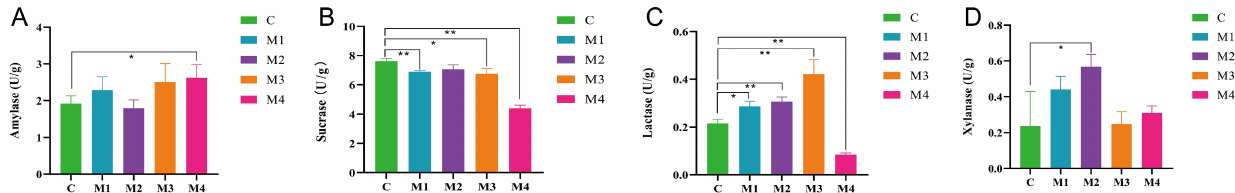
Figure 6. Effects of adenine combined with Folium sennae modeling on the intestinal mucosa enzyme activities of diarrhea mice. (A) Amylase activity. (B) Sucrase activity. (C) Lactase activity. (D) Xylanase activity. Data were expressed as mean ± standard deviation, n = 6, * P < .05, ** P < .01.